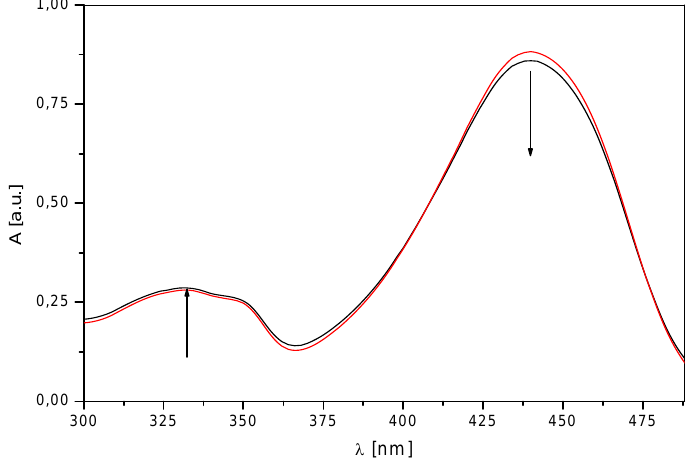
Figure 8. Absorption spectra of 4d in methanol (sample irradiated after heating ( ⎯⎯ ), sample heated after irradiation ( ⎯⎯